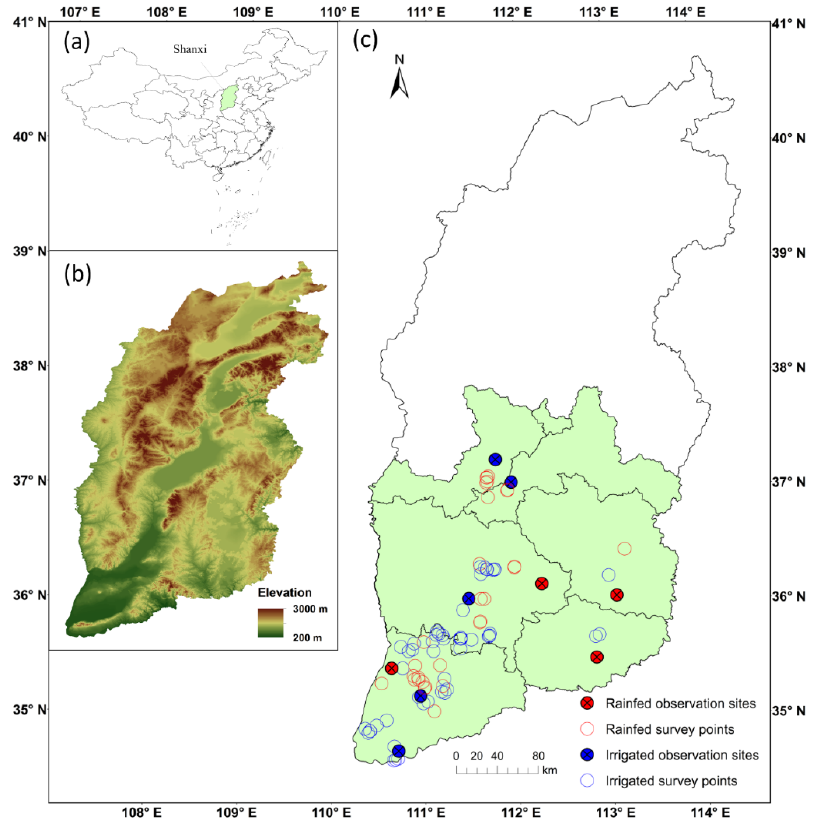
Figure 1. Location of Shanxi Province ( a ); digital elevation map ( b ) and spatial distribution of irrigated and rainfed observation sites and survey points ( c ) across the study area. The irrigated and rainfed observation sites represent agrometeorological stations, while the survey points represent random selected ground survey